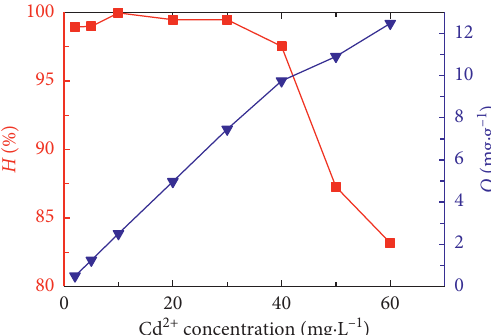
Figure 8: Percent removal of Cd 2+ ion H (- ■ -) and the amount of adsorbed Cd 2+ ion at equilibrium conditions Q (- ▲ -) of the FAMBT particles at different Cd 2+ concentrations.